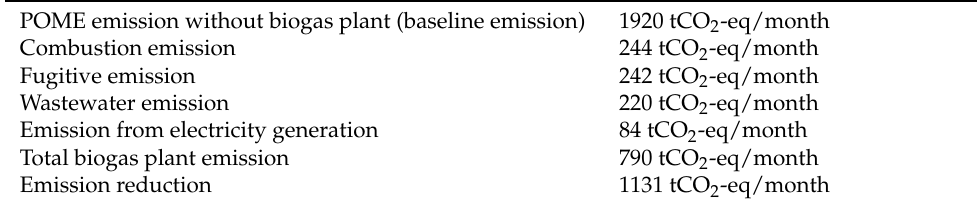
Table 4. Benefits of reducing GHG emissions with a biogas plant.